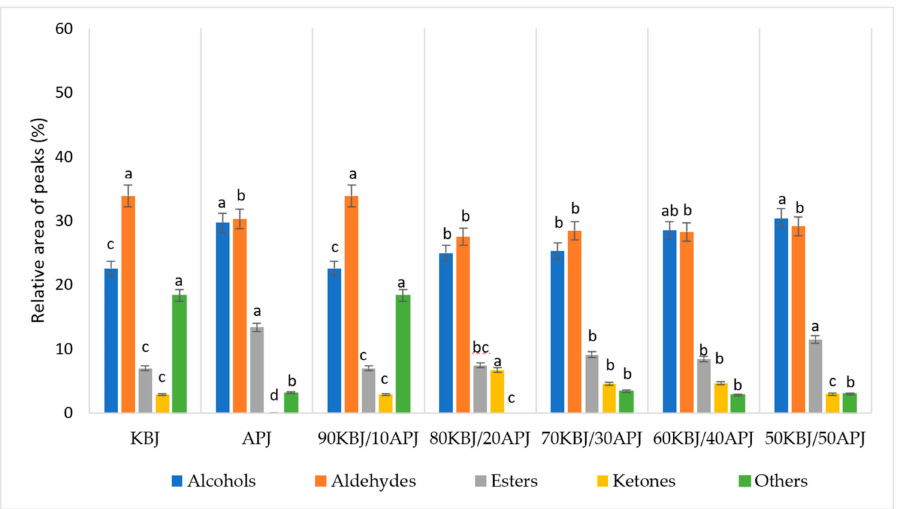
Figure 1. Relative area of peaks (%) for the MTX-G column of the main volatile compounds identified in the headspace of kiwiberry and apple juice and their mixes. Means ( n = 3) with different small letters (a–d) in the same chemistry family group are significantly different ( p ≤